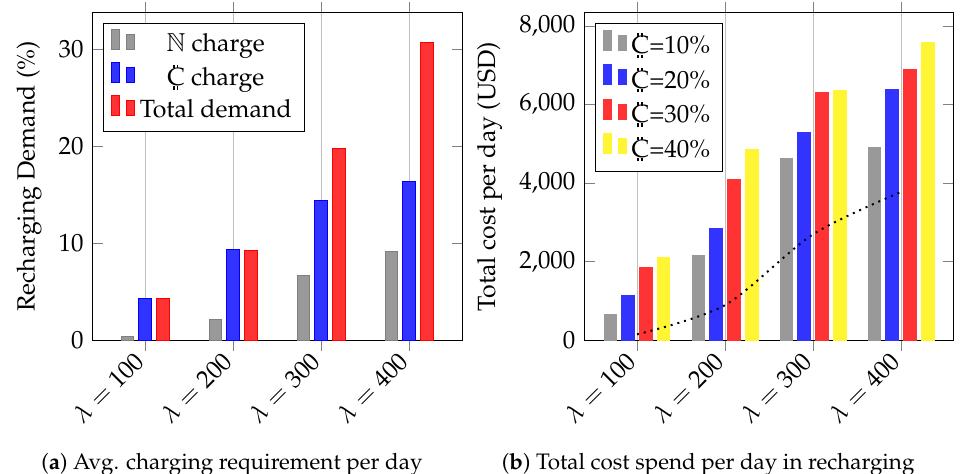
Figure 3. Showing the demand fluctuation due to cryptojacking, the overall cost EV owners paid (loss), and system efficiency.